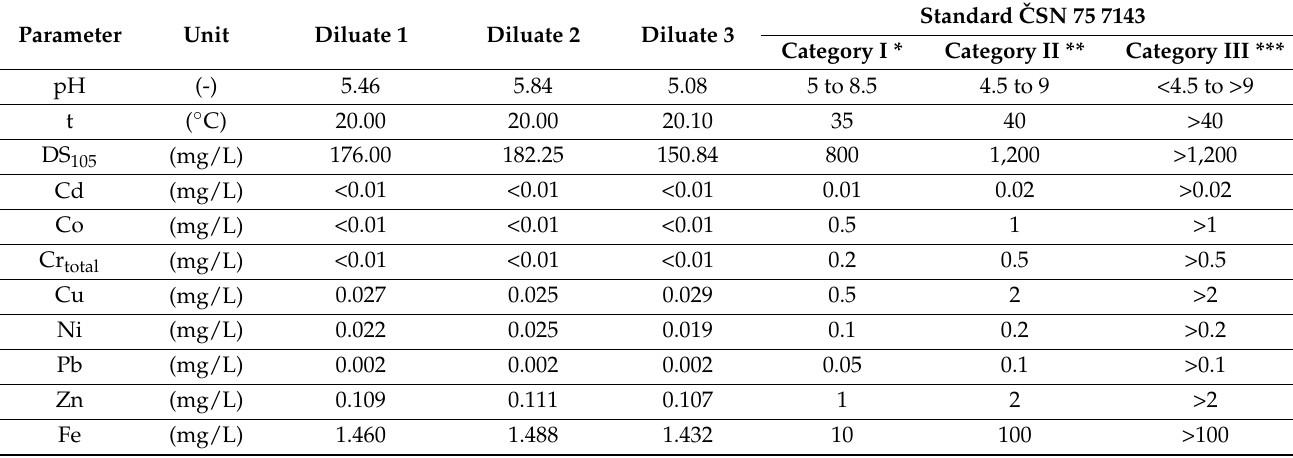
Table 7. Classification of the different sample parameters into water quality classes according to Standard ˇCSN 75 7143.